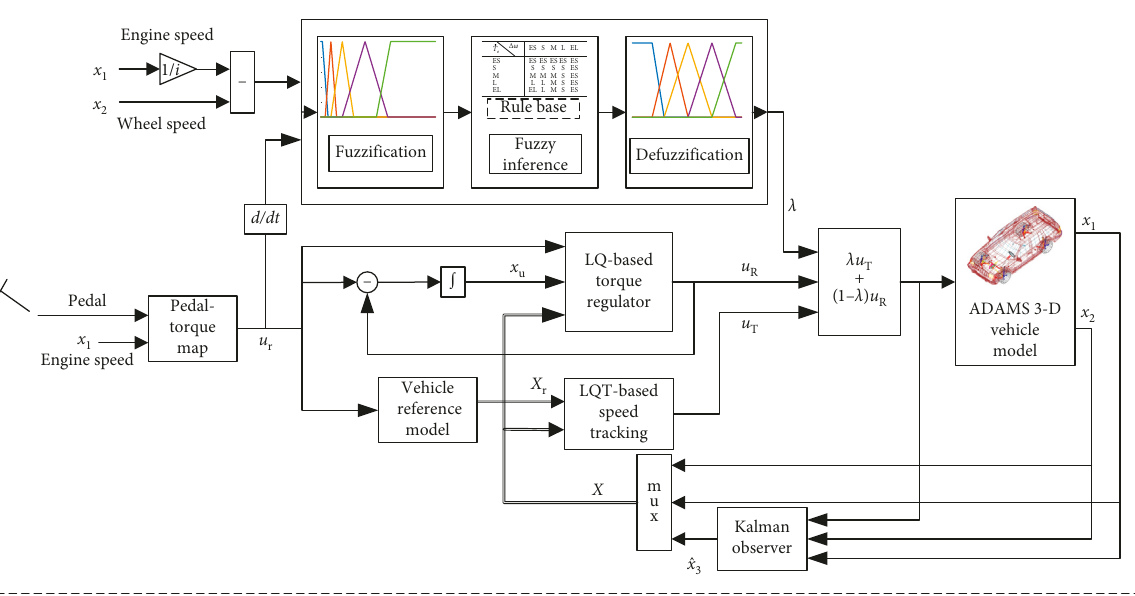
Figure 7: Fuzzy switching control structure.